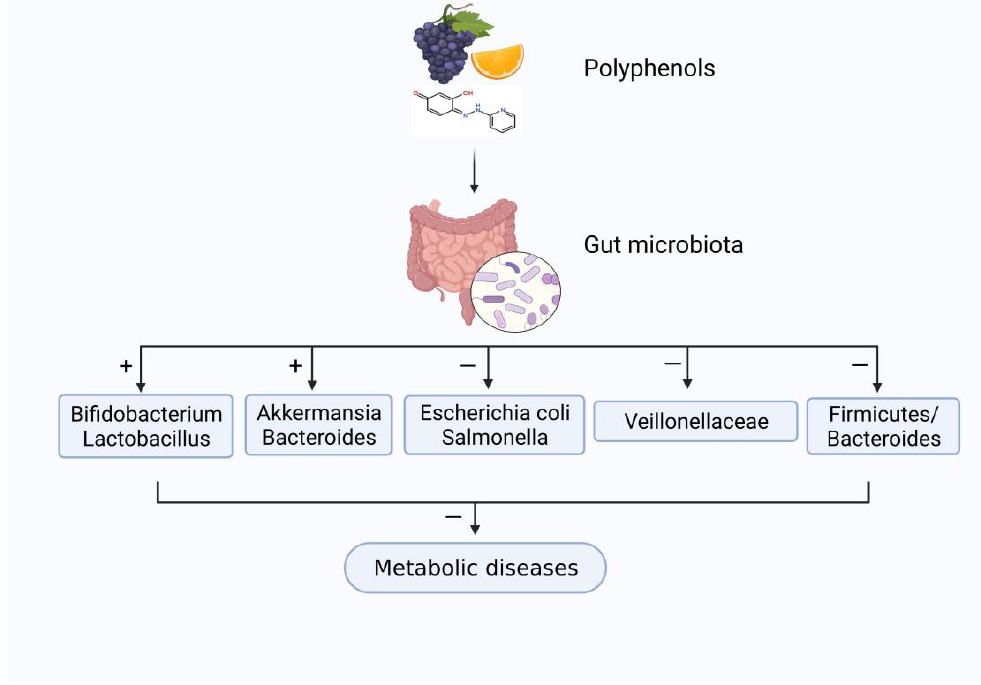
Figure 3. The influence of the interaction between plant polyphenols and gut microbiota on metabolic diseases. “+” means “enhance”; “−” means “weaken”.